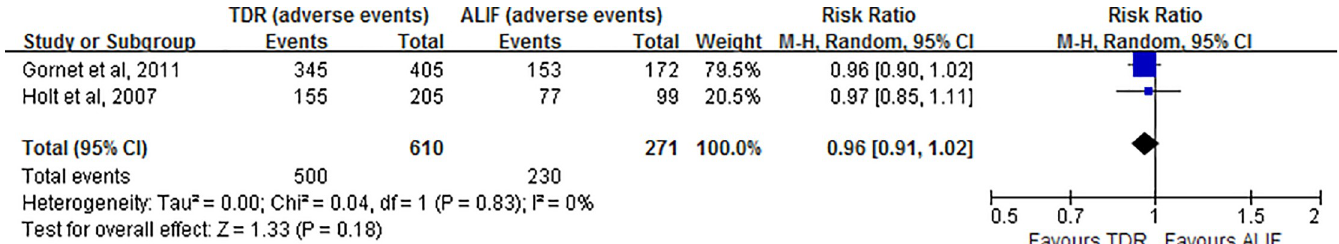
Fig 8. Forest plot for total adverse events. df = degrees of freedom, and M-H = Mantel-Haenszel.